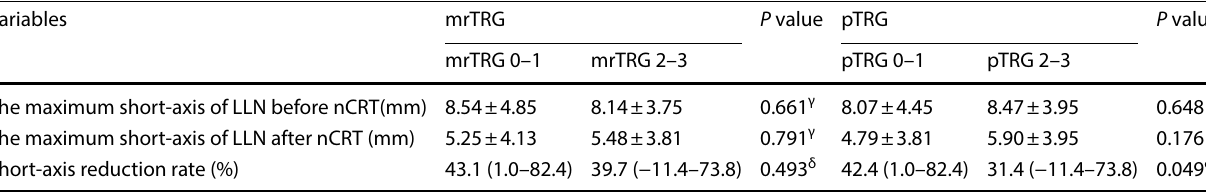
LLN Lateral lymph node; nCRT Neoadjuvant chemoradiotherapy; mrTRG : Magnetic resonance imaging tumor regression grading; pTRG Path- ological tumor regression